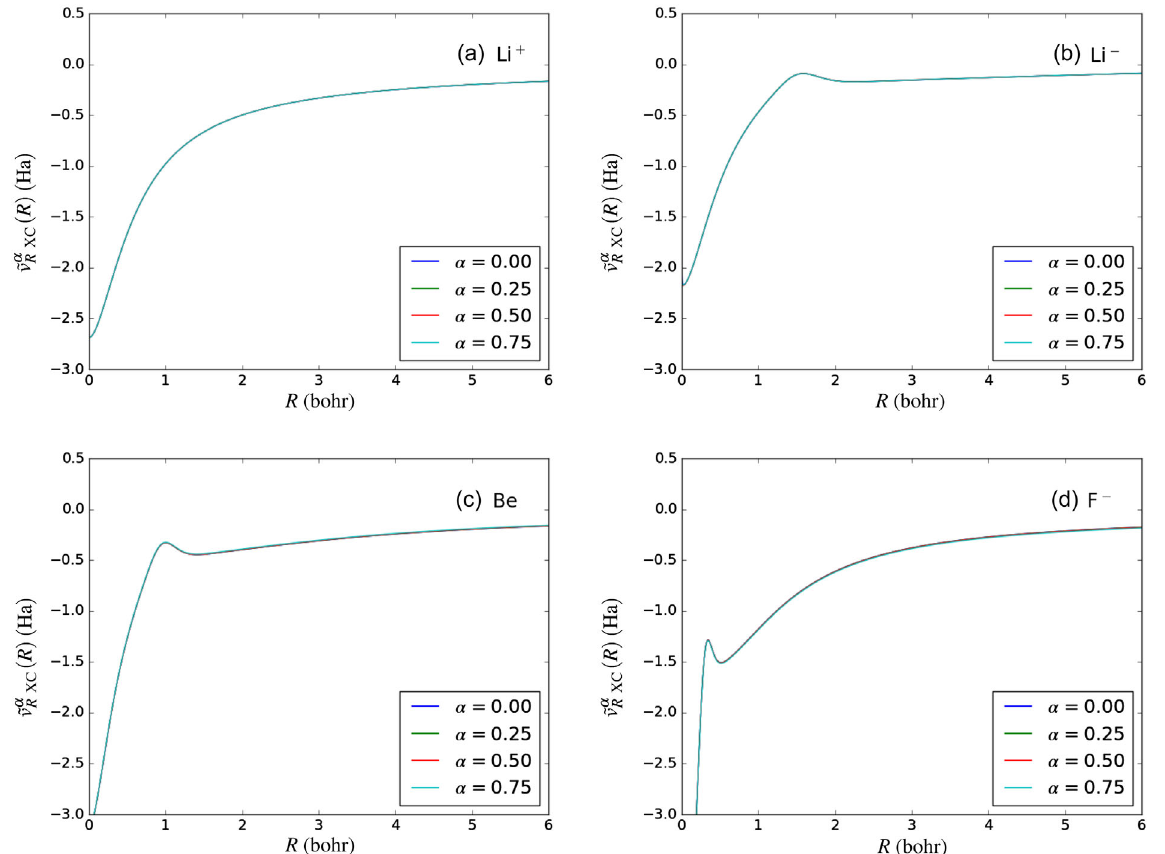
FIG. 3. Scaled remainder exchange potentials ˜ v α R; exchange for (a) Li þ , (b) Li − , (c) Be, and (d) F −